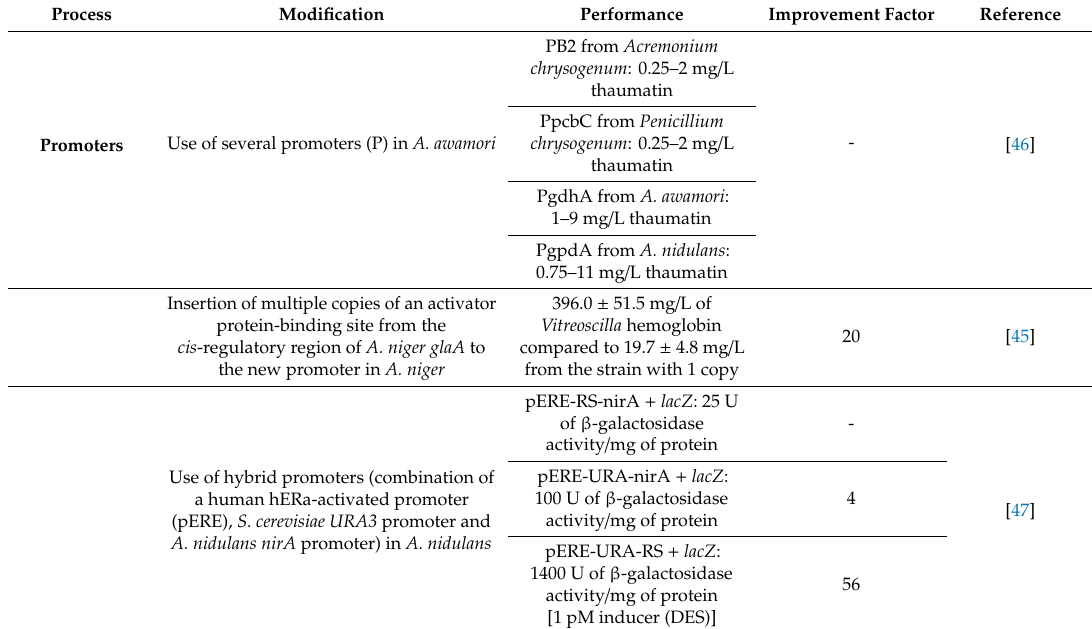
Table 2. Approaches for improving recombinant protein production through promoter